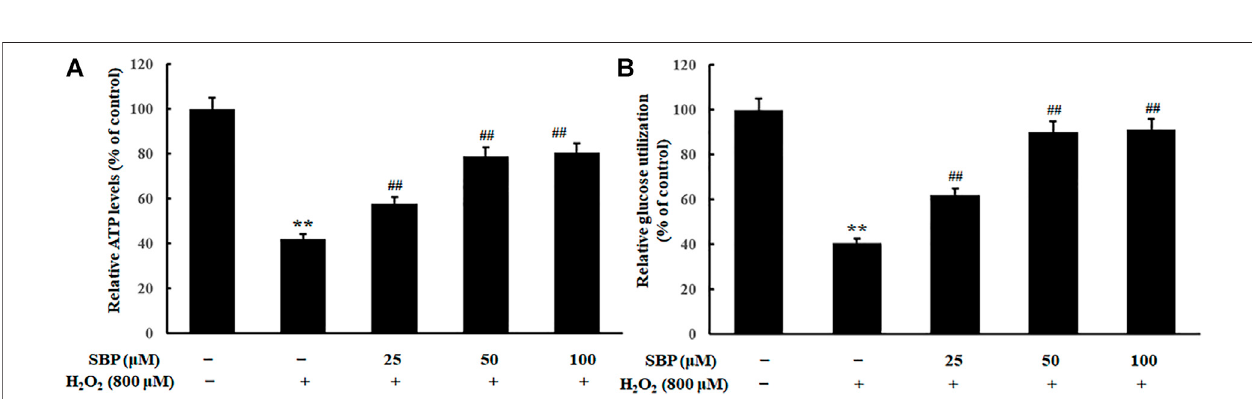
FIGURE 5 | Effect of SBP on the mitochondrial energy metabolism in RAW 264.7 cells. (A) Relative quantifying intracellular ATP levels in mitochondria after treatment with SBP. Representative fl ow cytometric histograms of each group. (B) Relative quantifying cellular glucose utilization in mitochondria after treatment with SBP. ATP content and glucose utilization were measured after 24 h treatment. ** p < 0.01 compared to the control group; ## p < 0.01 compared to the H 2 O 2 - treated group.